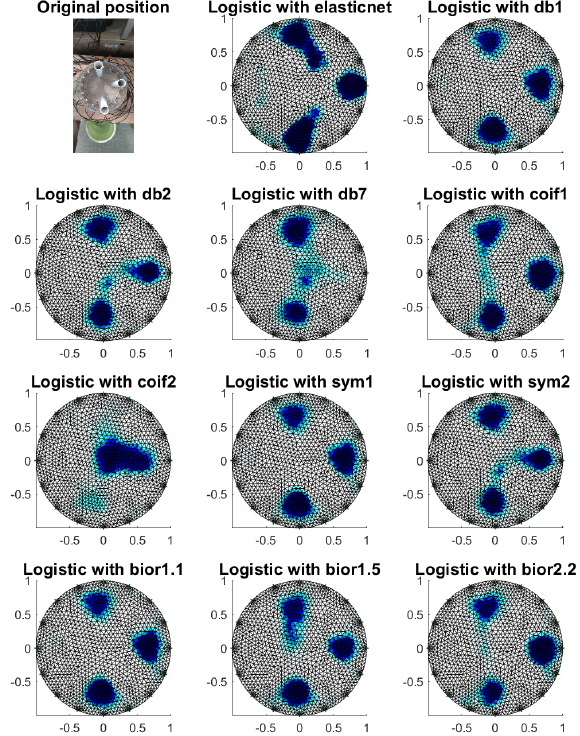
Figure 20. Image reconstruction with phantoms at electrodes 1, 5 and 9.